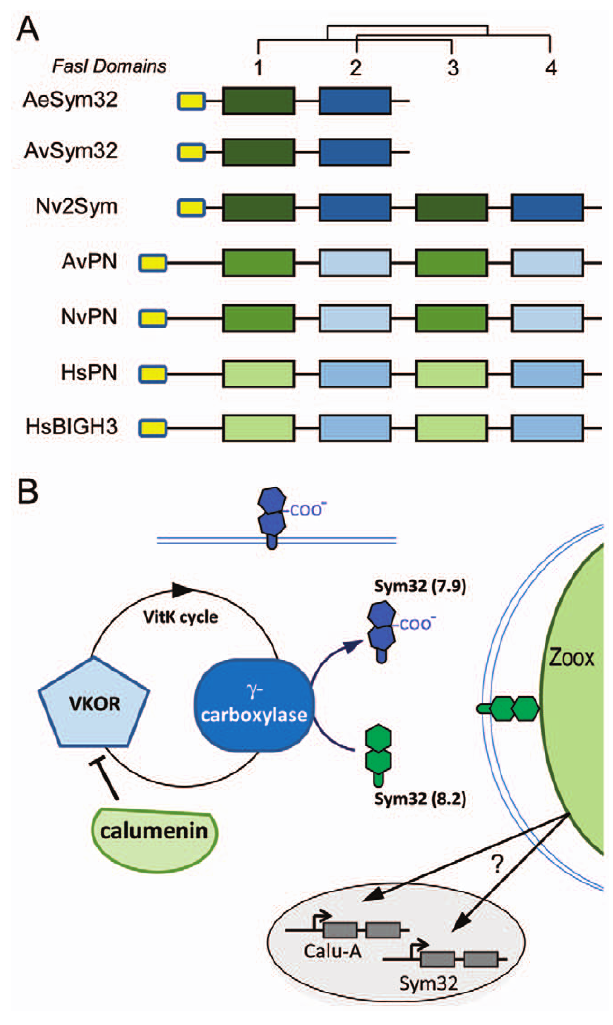
Figure 7. Sym32 gene duplication and putative c -carboxylation regulation model. A. Color code schematization of the PhyML tree for the FasI domains of the Sym32, Periostin (PN) and BGH3 homologs in sea anemones (Ae, A. elegantissima ; Av, A. viridis ; Nv, N. vectensis ) and human (Hs) (see tree in Figure S7b). Each rectangle represents one FasI domain (small yellow rectangles represent the Signal Sequence). FasI domains 1 and 3 are closely related. The first FasI domains of [AeSym32-1, AvSym32-1 and Nv2Sym-1 and -3] are closely related to each other and to a lesser extent with [AvPN-1 and -3, and NvPN-1 and -3] and finally with [HsPN-1 and -3, and HsBGH3-1 and -3]. A similar relationship exists for the FasI domains 2 and 4. AeSym32, AvSym32andNv2Sym are probable orthologs, except that Sym32 appears as the first half of Nv2Sym. The putative ortholog of HsPN is NvPN. B. Heuristic Model. The presence of symbionts activates the expression of calumenin and sym32 genes via an unknown mechanism. The CRS of the Sym32 protein is recognized as substrate by the activated vitamin K cycle (vitamin K is a cofactor produced from the photosynthetic organism) and in turn is c -carboxylated. Meanwhile, the Calumenin represses the VKOR protein, inhibiting the c -carboxylase. Two forms of Sym32 are thus expected to be produced from this pathway: the Glu-Sym32 and Gla-Sym32 electrophoretypes (likely corresponding to the two spots PI=8.2 and PI=7.9, respectively [51]). Only Sym32 (PI=8.2) is found to be associated with the symbiosome membrane, underlying